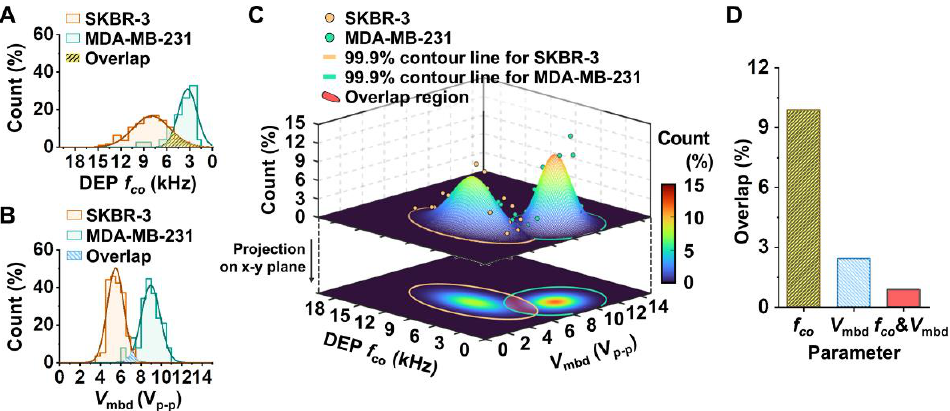
Figure 3. Electrical phenotyping of SKBR-3 cells and MDA-MB-231 cells. ( A , B ) Representative 1D histogram and Gaussian normal distribution concerning DEP f co ( A ) and V mbd ( B ). ( C ) Representative 2D Gaussian normal distribution of f co and V mbd . Each dot denotes the bin frequency (%) of DEP f co and V mbd in each cell population. This distribution is projected on DEP f co and V mbd and expresses the density plot of the 2D Gaussian distribution. The yellow and green lines represent the contour line that occupies 99.9% of the count region of 2D Gaussian distribution for SKBR-3 ( n = 113 cells) and MDA-MB-231 ( n = 76 cells) cell populations, respectively. The red region represents the overlapping area between the two distributions. ( D ) The overlapping occupancy (%) between the two breast cancer cell population distributions using DEP f co , V mbd , and both f co and V mbd .